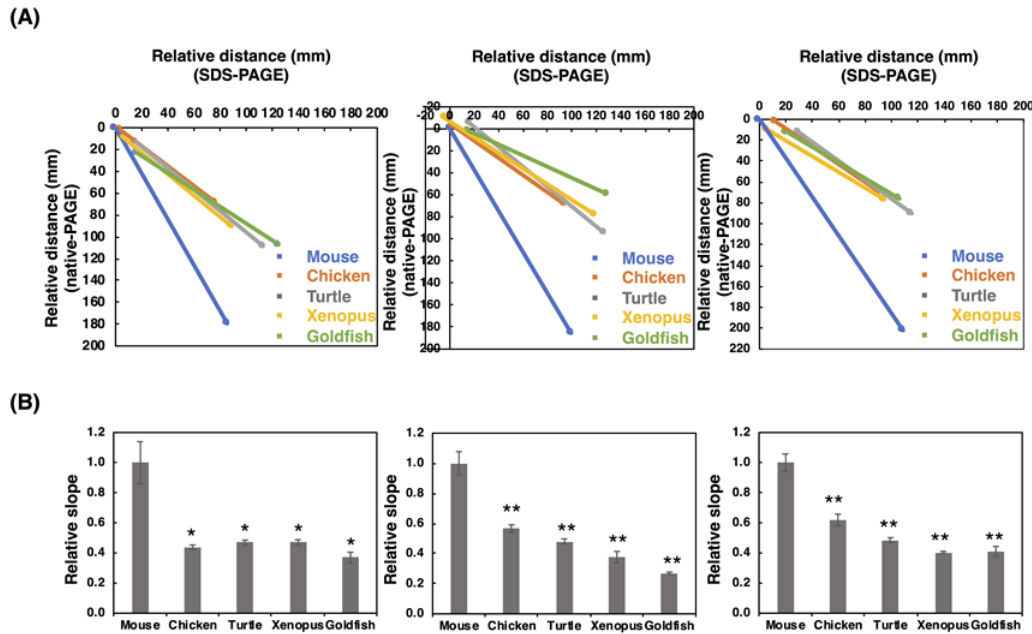
Figure 4. SDS-PAGE/native-PAGE MAP. The S/N MAP of brains from five different vertebrates is described based on the results of blots with each antibody. The results of SDS-PAGE (Figure 2) and native-PAGE (Figure 3) were used. ( A ) The typical S/N map of 12E3, 735, and 12F8 staining. ( B ) Relative slope value, K. The value for mouse was set to 1.0. The left, middle, and right panels stand for 12E3, 735, and 12F8, respectively. The values were obtained from the S/N maps from five different vertebrate brains (n = 3). * indicates p < 0.05. ** indicates p < 0.01.